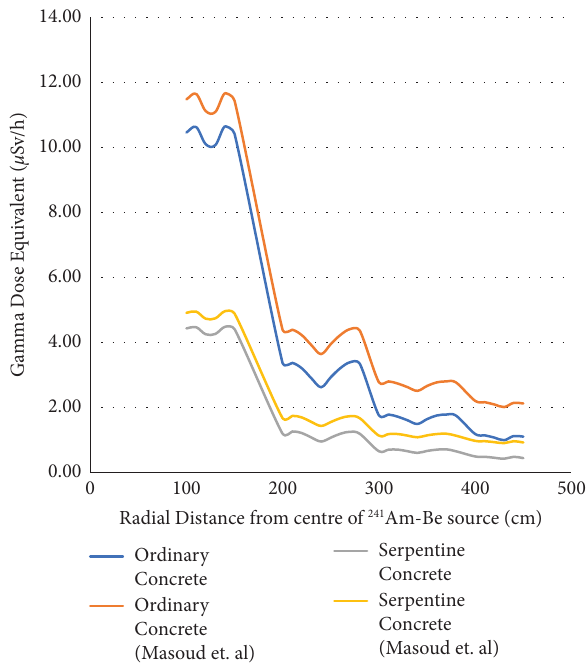
Figure 8: Comparison of results of gamma dose equivalent versus radial distance from the centre of 241 Am-Be source with literature.